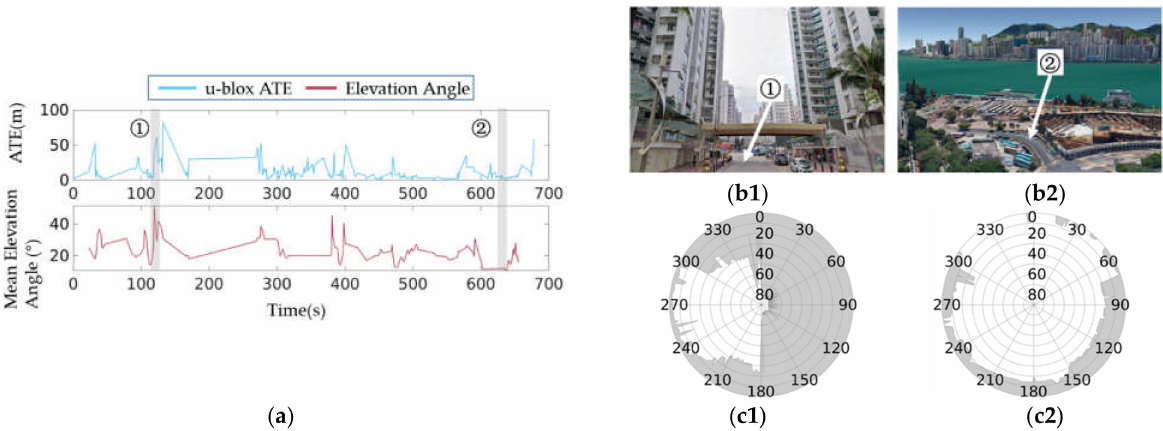
Figure 8. ( a ) The top panel shows the ATE of the u-blox RTK solutions produced by RTKLIB [7] collected in urban-2. The bottom panel shows the mean elevation angle mask of the local point cloud map around the correspondent u-blox epoch. The mean elevation angle mask is defined as that of a fixed-size local map with 50 m (Euclidean distance) both forward and backward the rover. Thus u-blox epochs within 50 m from the start and the end have no corresponding mean elevation angle masks. 1 (cid:13) and 2 (cid:13) denote representative cases. ( b1 , b2 ) are streetscapes of the three places denoted in ( a ) respectively. ( c1 , c2 ) are the sky masks of the two places denoted in ( a )